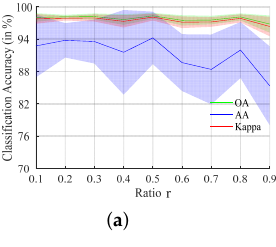
Figure 13. The influence of the ratio r of high-frequency channels to low-frequency channels on the performance of IFormer networks. The margin of error is expressed as the standard deviation of the evaluation index. ( a ) Indian Pines dataset. ( b ) University of Pavia dataset. ( c ) Salinas dataset. ( d ) Long Kou dataset.